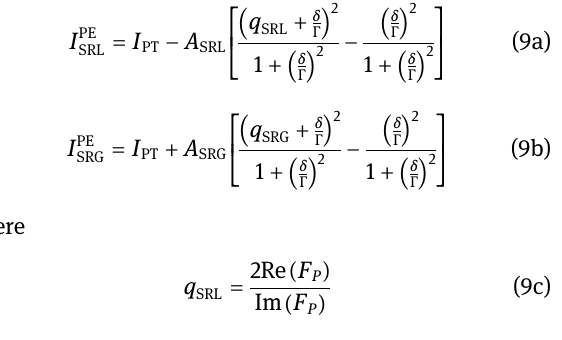
Figure 5: The experimental and simulated plasmon-enhanced stimulated Raman loss (PESRL) (a) and plasmon-enhanced stimu- lated Raman gain (PESRG) (b) spectra of adenine. The background-corrected PESRL and PESRG spectra are presented as solid lines (black, red, and blue). The Fano-like fitting spectral profiles based on eq. (9) are presented as the same color dash lines. Simulated PESRL and PESRG spectra based on eq. (8) are presented as green dot